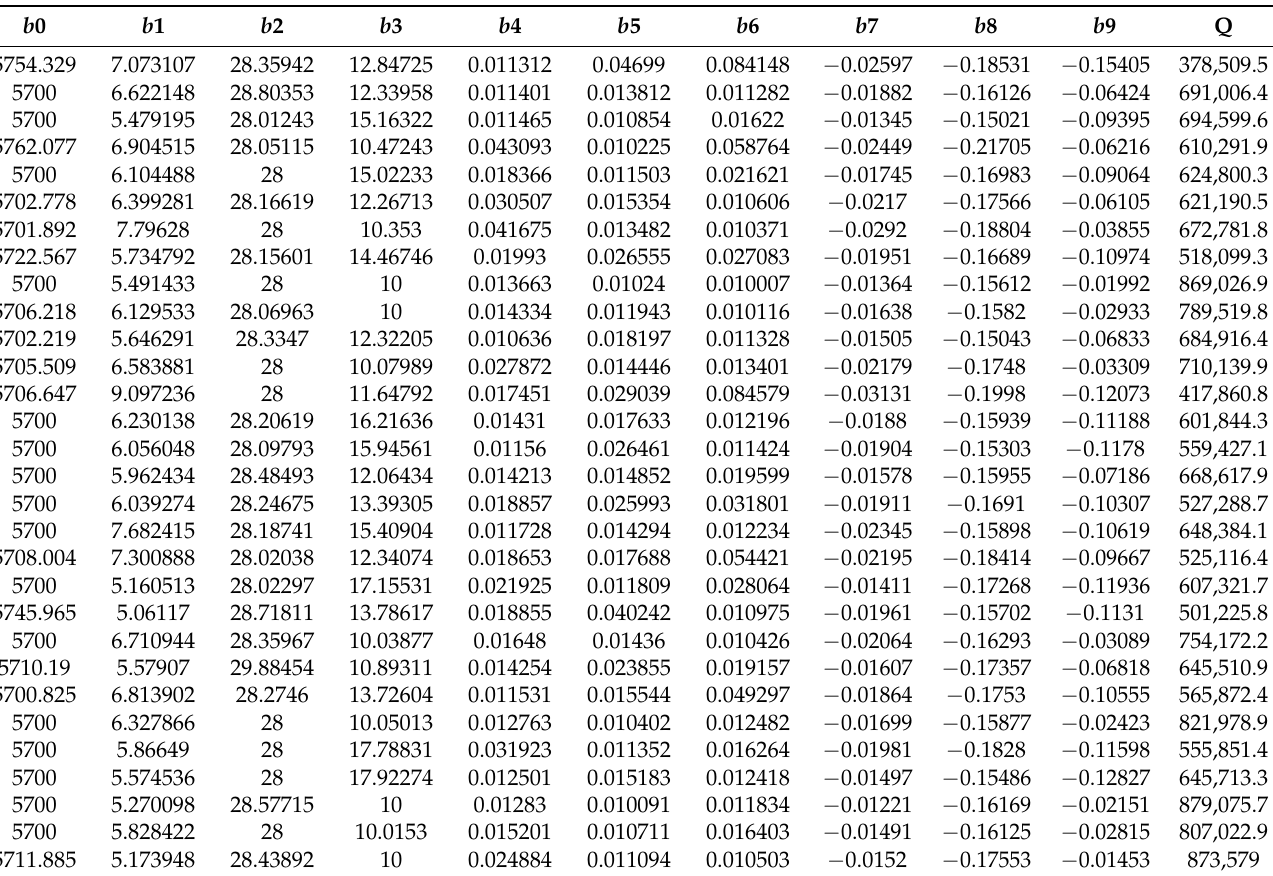
Table A1. Results of the coefficients of the fertilizer equation by